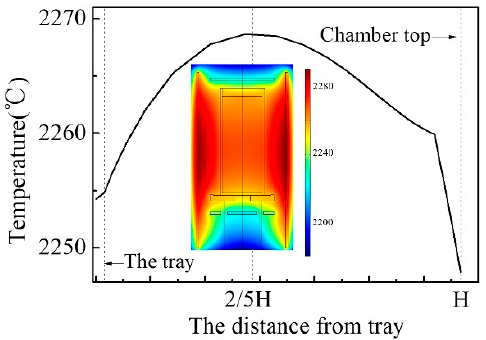
Figure 5. Temperature profile along axis of symmetry of the chamber. Inset displays thermal of the growth distribution of the growth chamber.